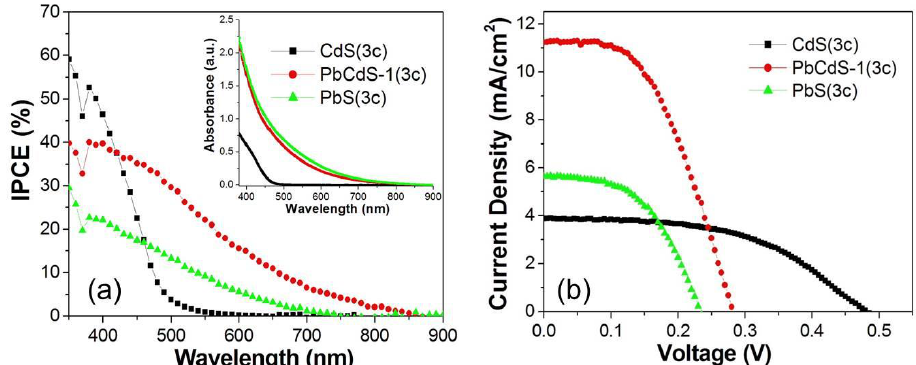
Figure 1. Incident photon to current efficiency (IPCE) spectra ( a ) and current–voltage (I–V) curves ( b ) of quantum-dot-sensitized solar cells (QDSCs) employing three successive ionic-layer adsorption and reaction (SILAR) cycles of CdS, PbS, and PbCdS-1 as photosensitizers. Inset of ( a ) is the absorption spectra of three-SILAR-cycle QD-sensitized TiO 2 films. “3C” means three SILAR cycles, and the bare